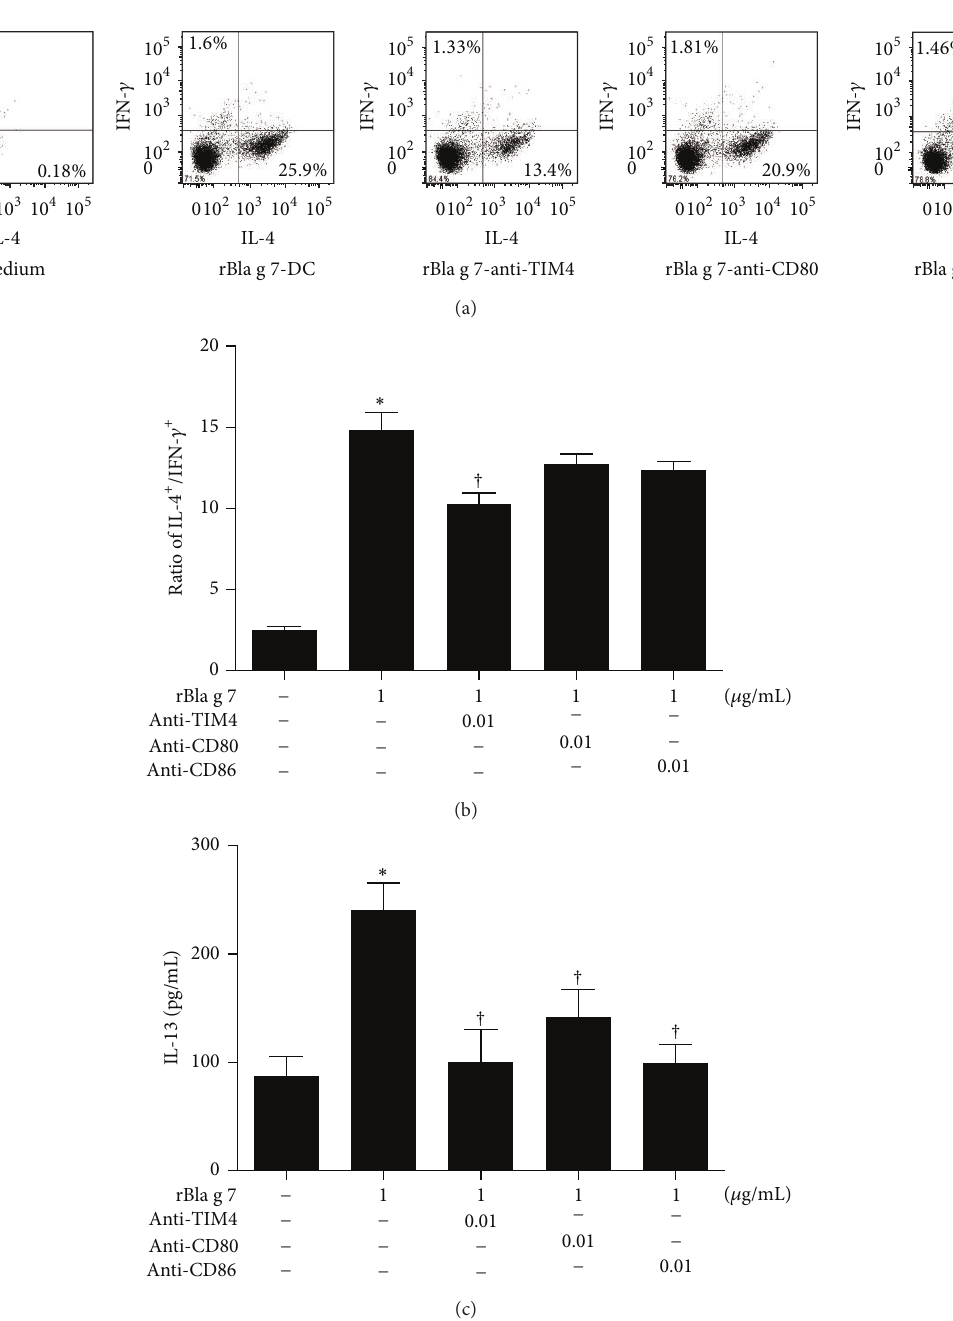
Figure 6: Inhibition of rBla g 7-stimulated dendritic cell (DC)s induced Th2 polarization by antibodies against TIM4, CD80, and CD86. In (a), isolated CD4+ T cells were cocultured with DCs treated with rBla g 7 (1 𝜇 g/mL) alone (rBla g 7-DCs) or treated with rBla g 7 and anti- TIM4 (10ng/mL, rBla g 7-anti-TIM4), anti-CD80 (rBla g 7-anti-CD80) or anti-CD86 antibodies (rBla g 7-anti-CD86) before flow cytometry analysis of intracellular expression of IFN- 𝛾 and IL-4 being performed. (b) The ratio of IL-4+ CD4+ T cells versus IFN- 𝛾 + CD4+ T cells. (c) Levels of IL-13 in the supernatants of DCs determined by ELISA. The data were represented as the mean ± SEM for four separate experiments. ∗ 𝑃 < 0.05 in comparison with medium alone control. † 𝑃 < 0.05 compared with the response to the corresponding uninhibited